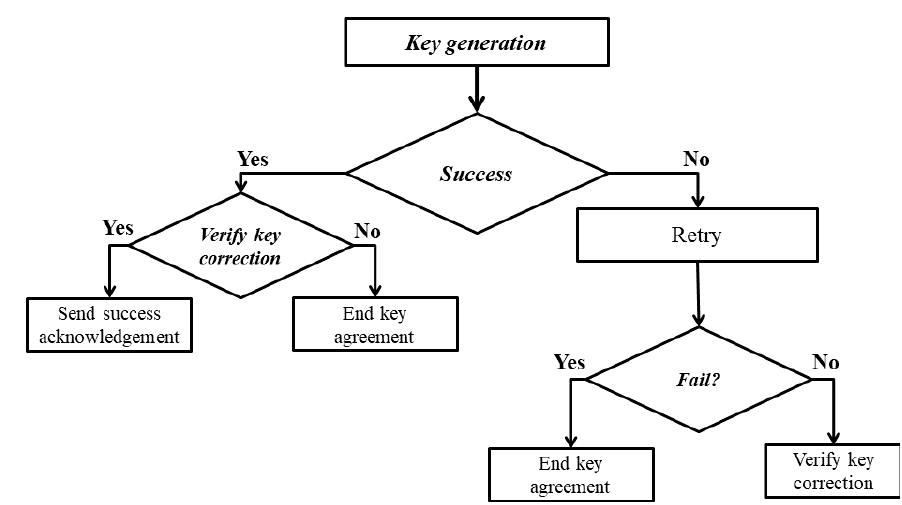
Figure 6. The key generation process at the receiver side.